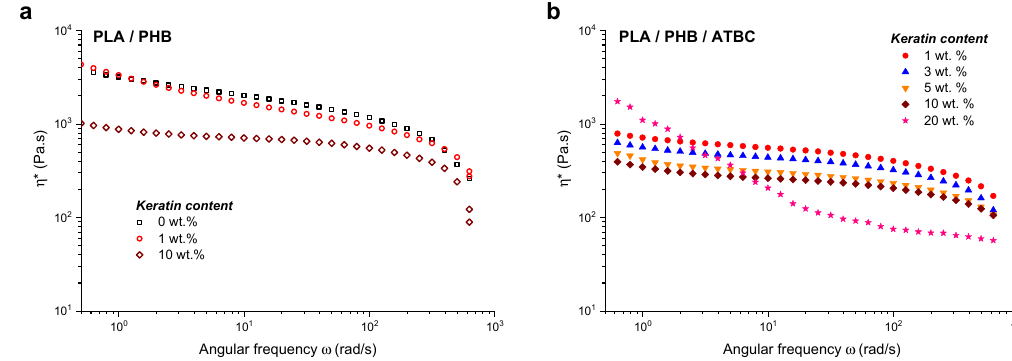
Figure 7. The dependencies of ( η *) on angular frequency ω for ( a ) neat PLA/PHB blend without keratin and with 1 wt % and 10 wt % of keratin loading and ( b ) PLA/PHB/ATBC blend with 1 wt %, 3 wt %, 5 wt %, 10 wt % and 20 wt % of keratin loading.